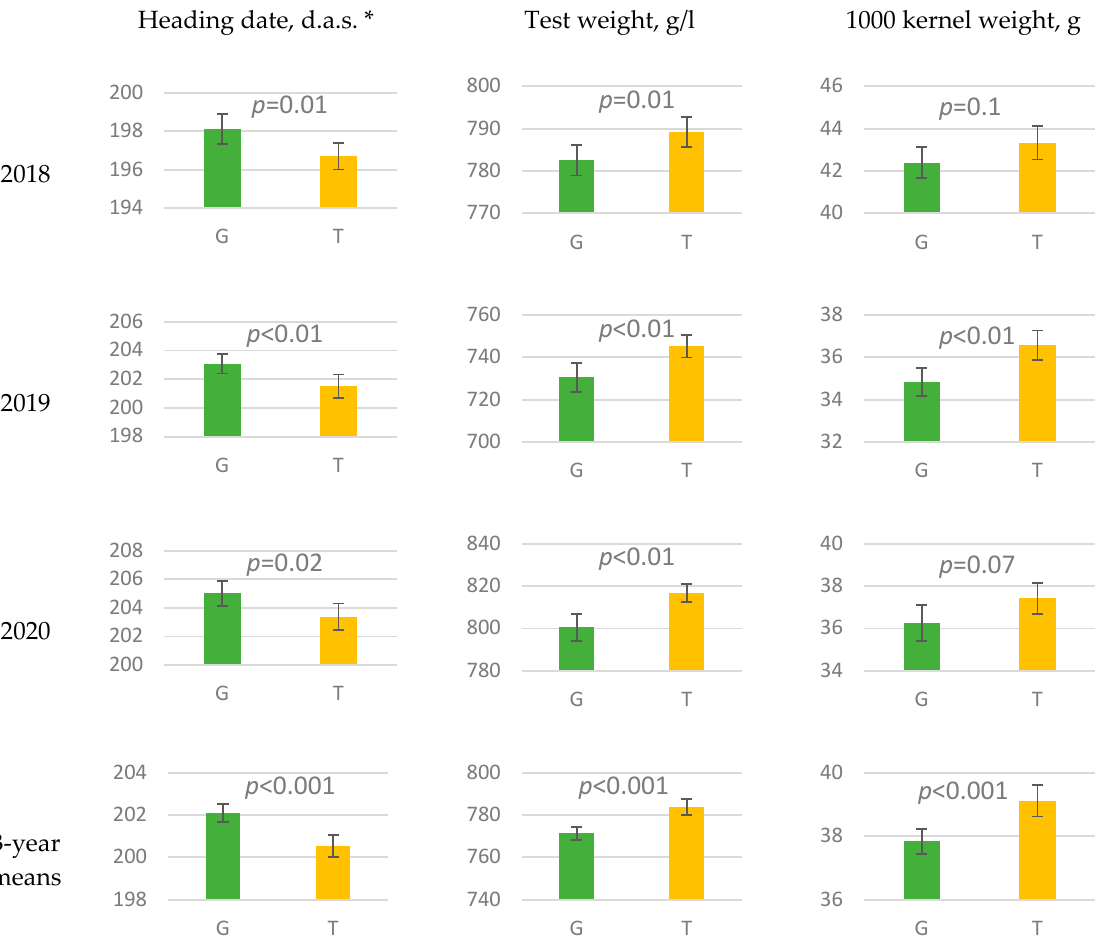
Figure 5. Heading date and grain traits for winter wheat accessions differing in missense mutation c.495G>T in TaGRF3-2A tested in 2018–2020 at Krasnodar. Bars indicate 95% confidence intervals. The p -values are calculated for Fisher’s F-test. *—days after sowing.